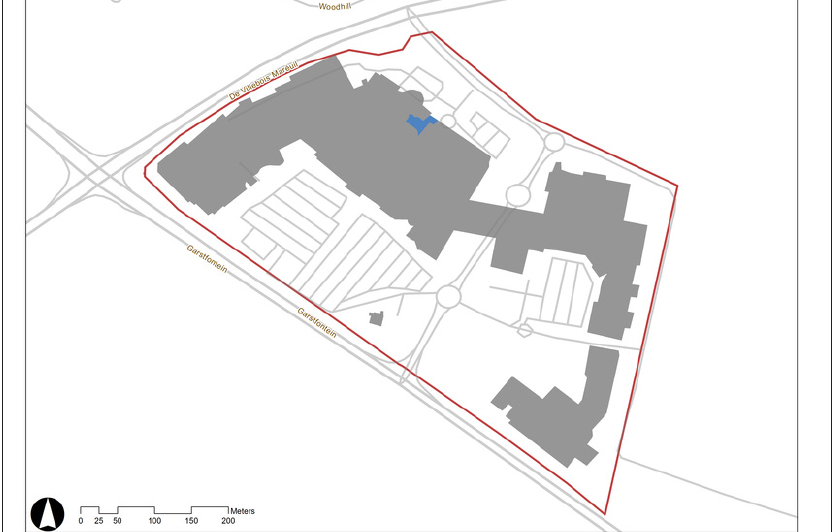
Figure 7: The form and location of the quasi-public space in Woodlands Mall Source: Produced by Darren Nel, 2016